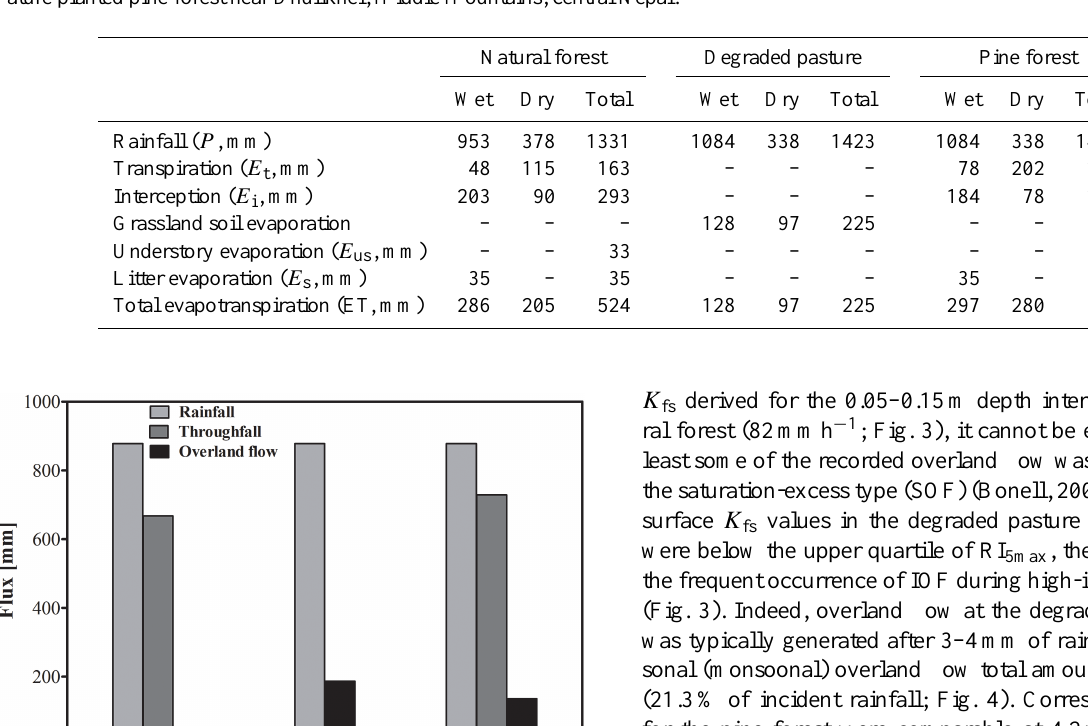
Table 1. Summary of rainfall and estimated evapotranspiration components for a natural broadleaved forest, a degraded grassland, and a mature planted pine forest near Dhulikhel, Middle Mountains, central Nepal.